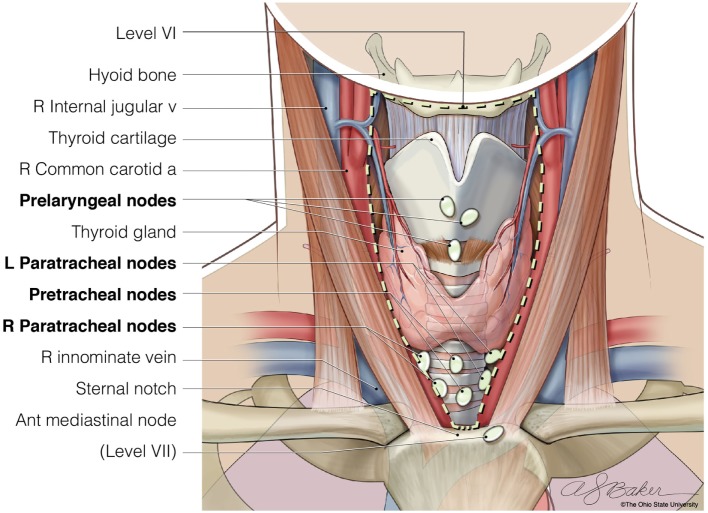
The anatomic borders of Level VI of the central neck (hyoid bone, carotid arteries, and sternal notch), where lymph nodes are resected when completing a bilateral central neck dissection. © Ohio State University.